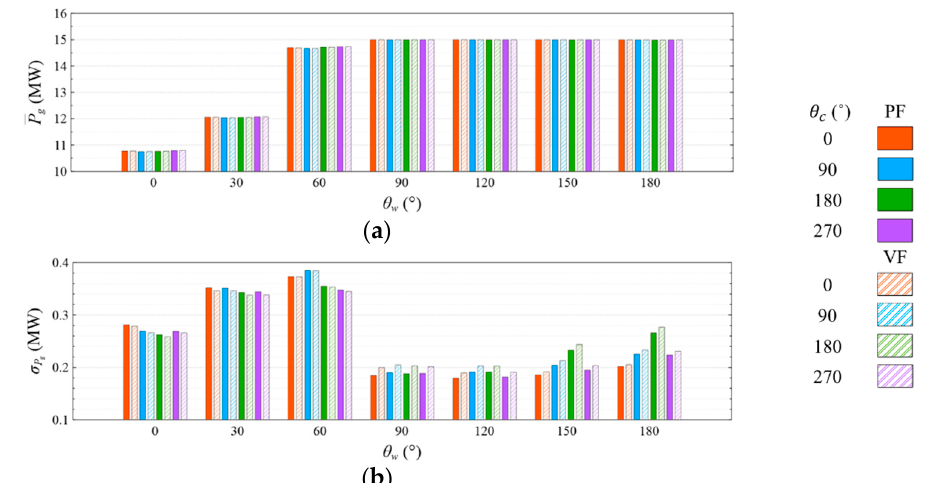
Figure 27. Comparison of ( a ) means and ( b ) standard deviations of generator electrical power under HW condition.